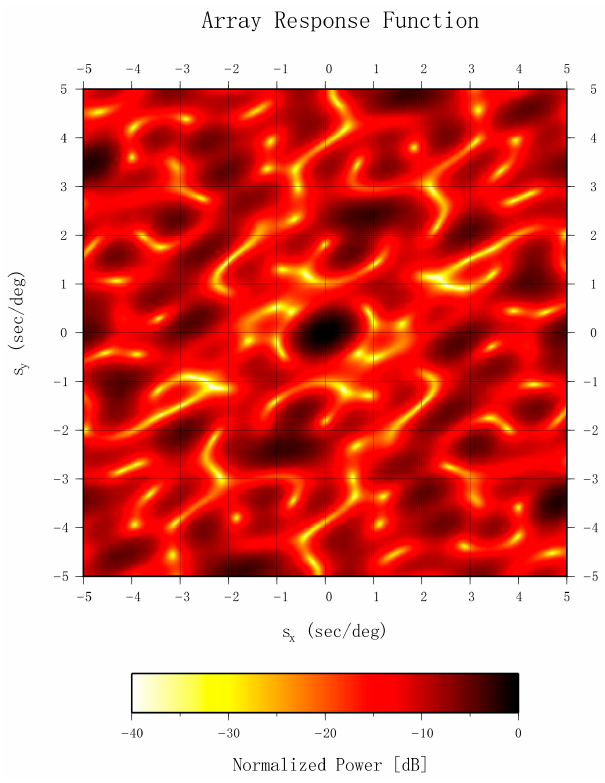
Figure 2. The array response function of YL array.